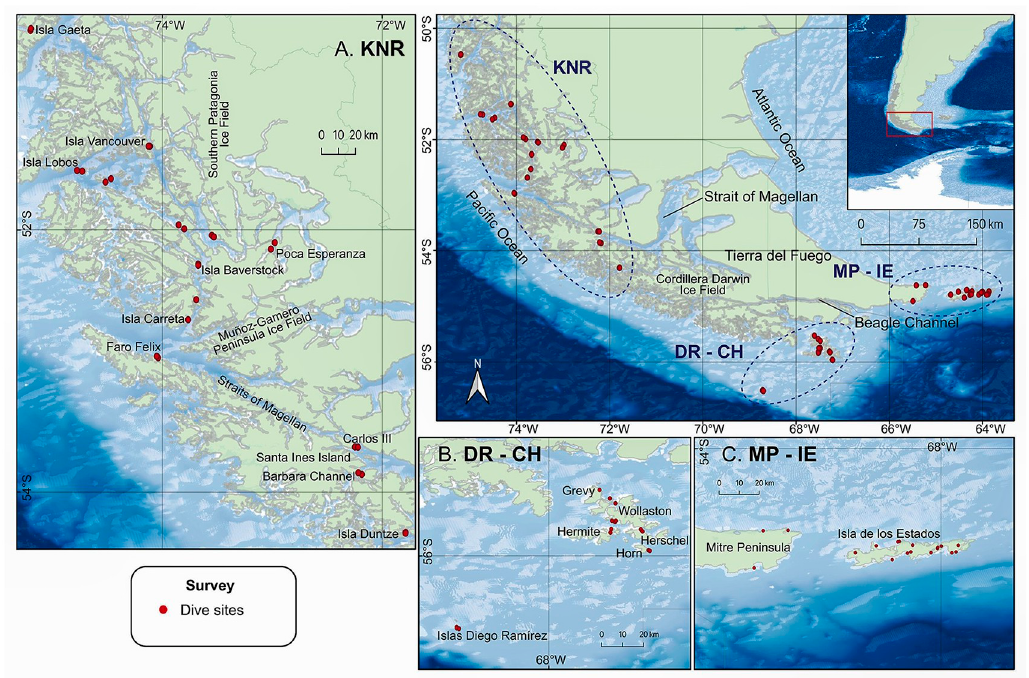
Fig 1. Sampling stations in southern Patagonia. A. KNR = Kawe´sqar National Reserve, B. DR = Diego Ramı´rez and CH = Cape Horn Archipelago, C. MP = Mitre Peninsula and IE = Isla de los Estados. Basemap derived from GEBCO Compilation